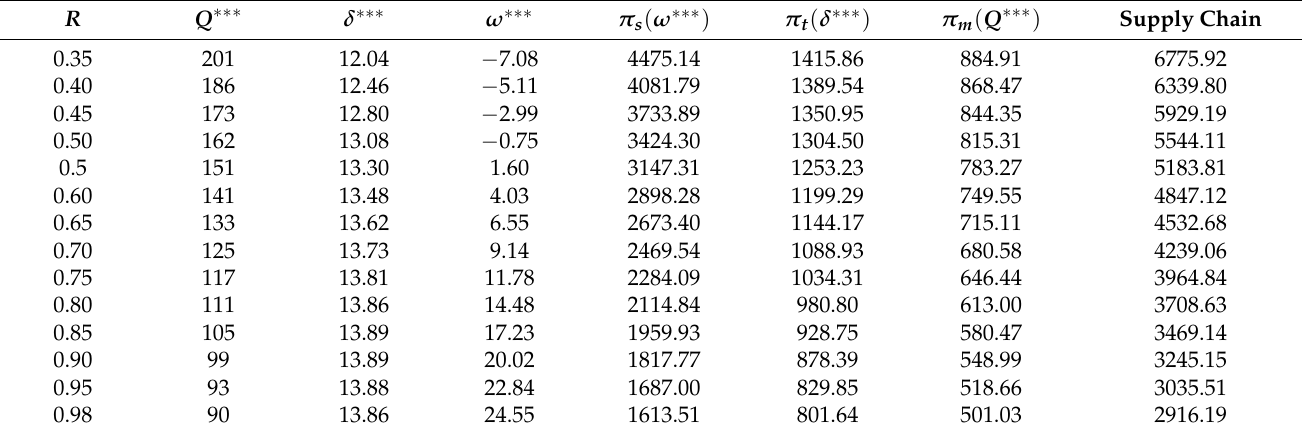
Table 4. Impacts of revenue sharing on decision variables and